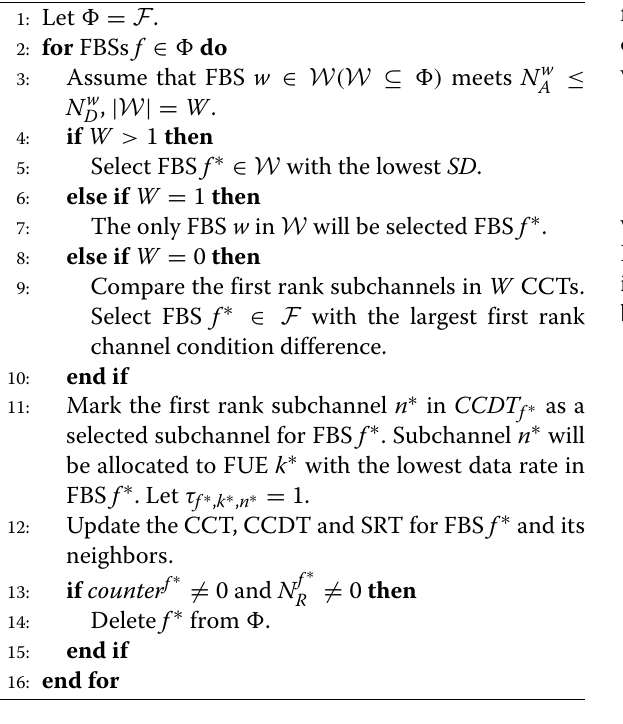
Algorithm 1 Distributed fairness-based subchannel allocation algorithm(DFSA)